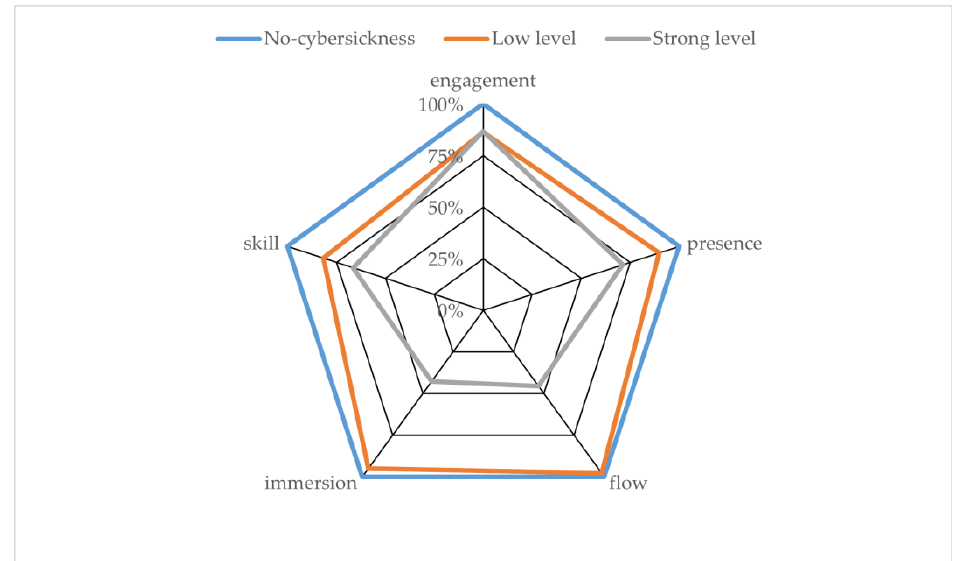
Figure 9. Radar plot of the usability and satisfaction survey results of the low and the moderate levels of cybersickness groups showing their percentage differences with the no-cybersickness group.